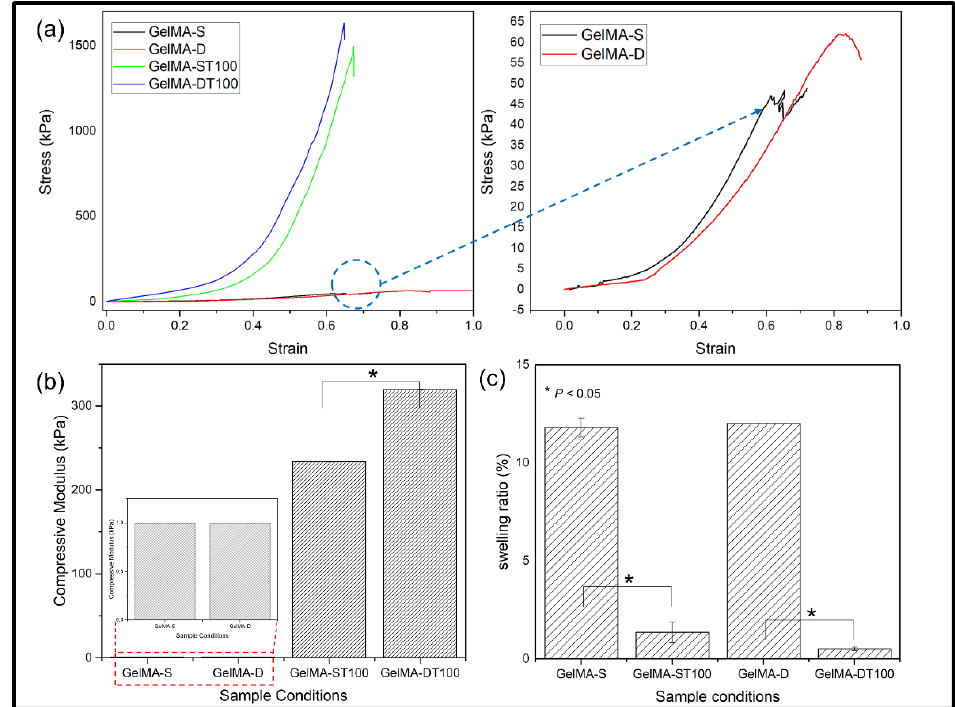
Figure 3. Mechanical properties of hydrogels (GelMA-S and GelMA-D) and after treated with the 100 w / v % of TA. The compression deformation of all hydrogels was performed up to 95%; ( a ) Stress- strain Curve for hydrogels, ( b ) Compressive Modulus through (0~20% slope), ( c ) Swelling ratio of GelMA and GelMA-TA hydrogels. (Data are presented as mean ± SD, n = 3, * p < 0.05).